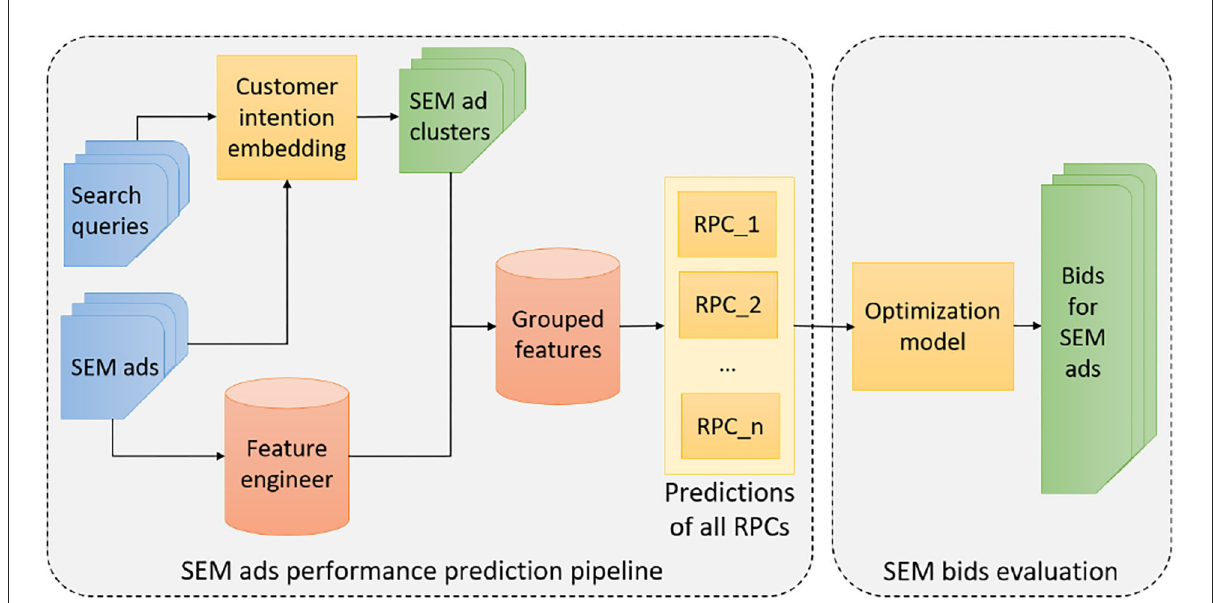
FIGURE1 Overview of the infrastructure for providing search engine marketing (SEM) ads’ bids by our approach.